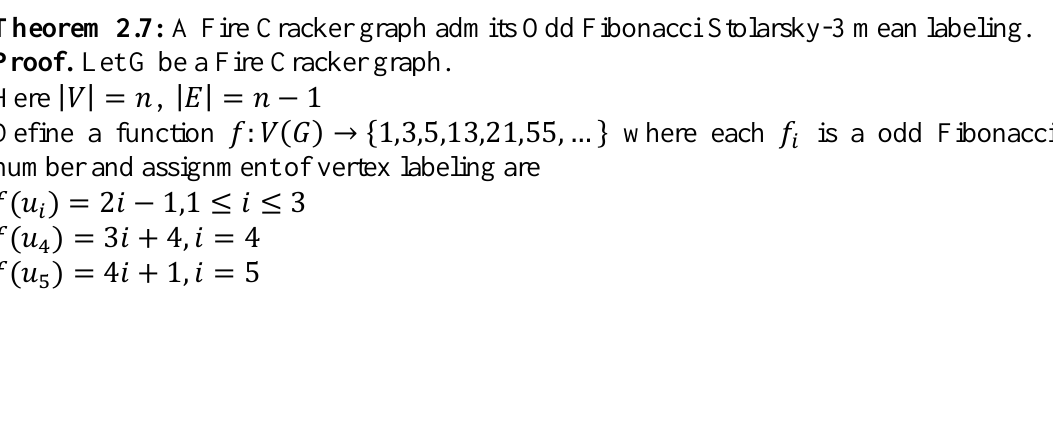
Figure 2.3 (5, 1)- tadpole